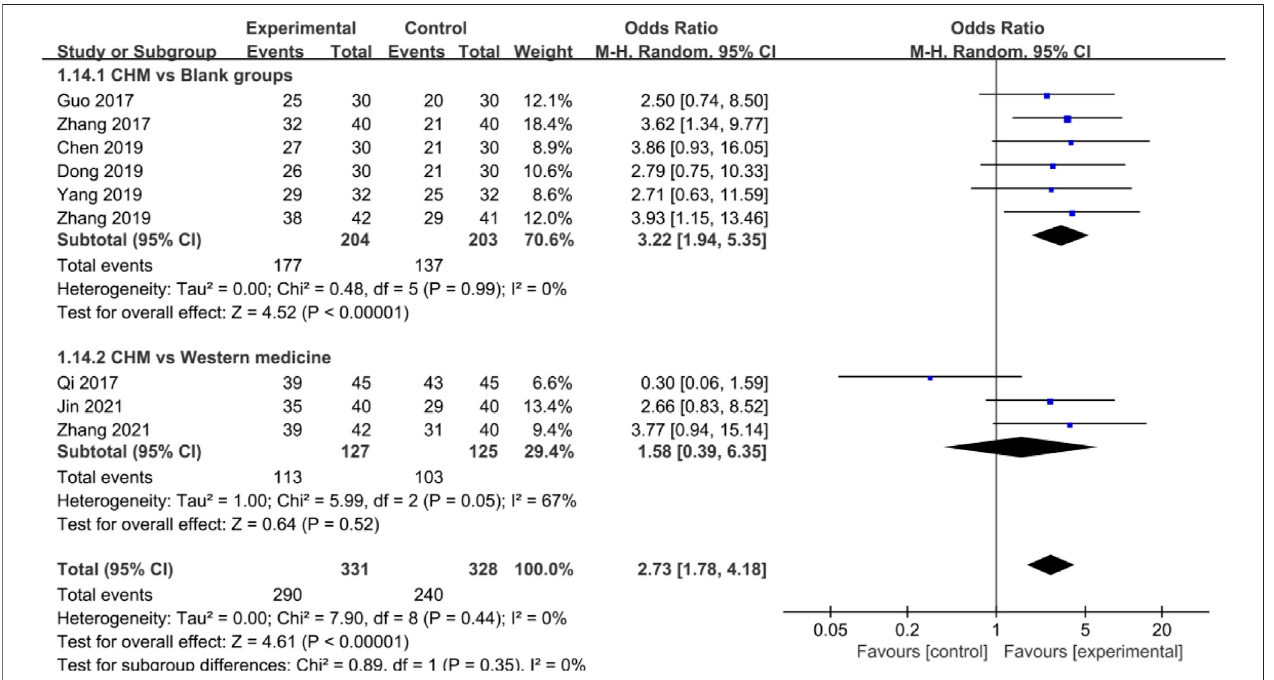
FIGURE 2 | Forest plot: CHM improved HAMA ef fi cacy in CHD with anxiety compared with control groups.